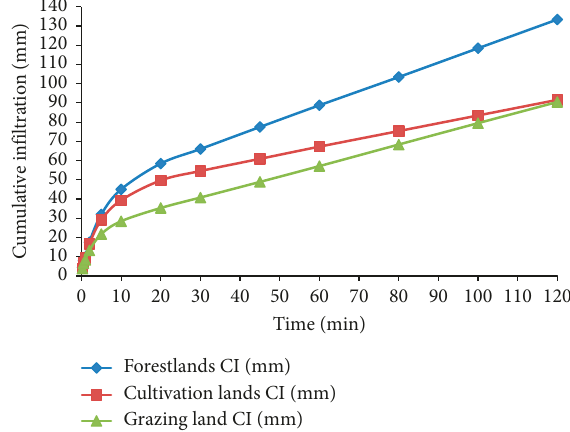
Figure 4: Cumulative infiltration curves for land use types, Geshy subcatchment.